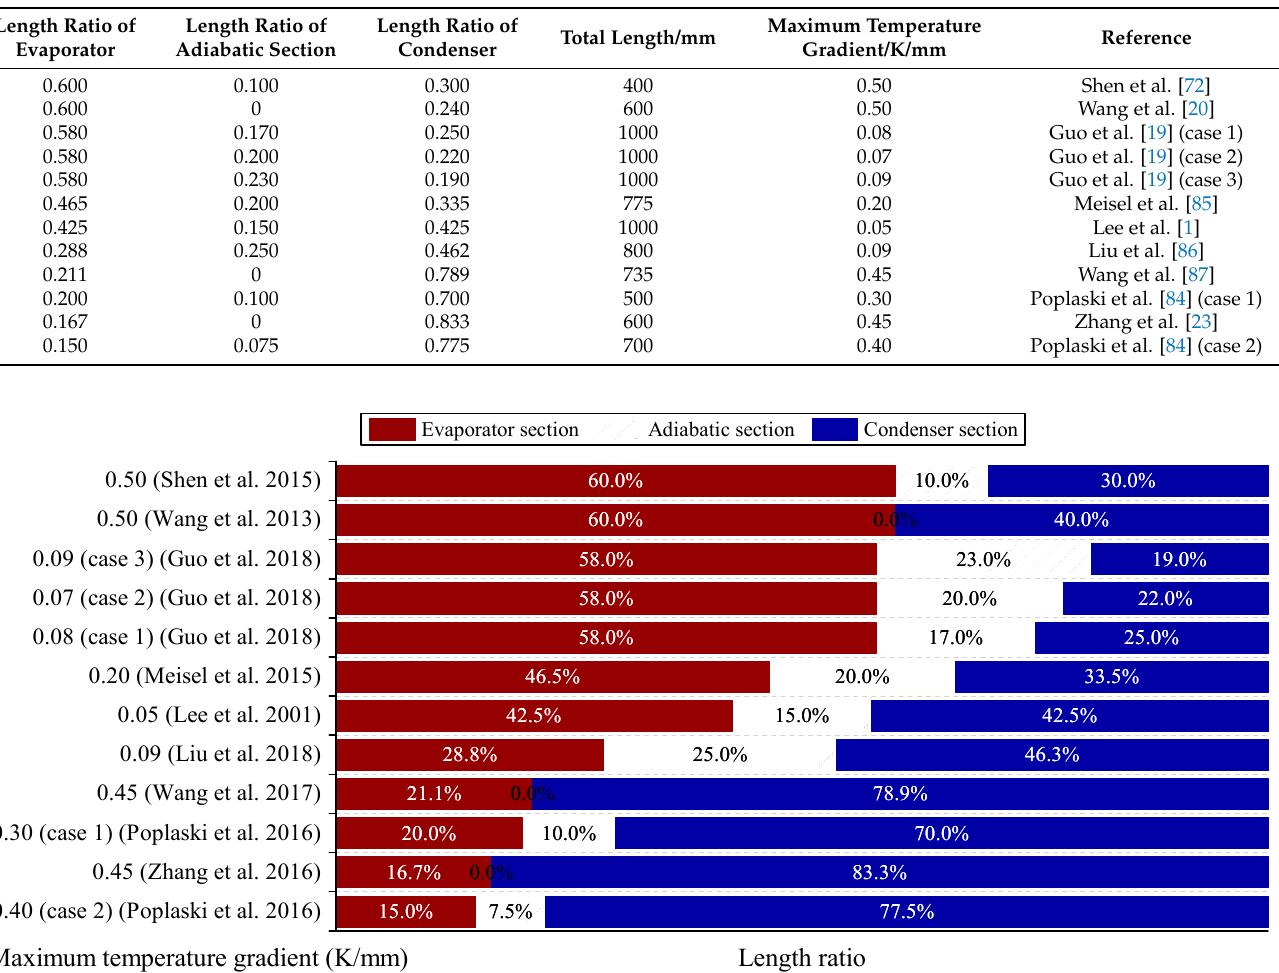
Table 7. Effect of the isothermal performance on length ratio of each section of heat pipes.